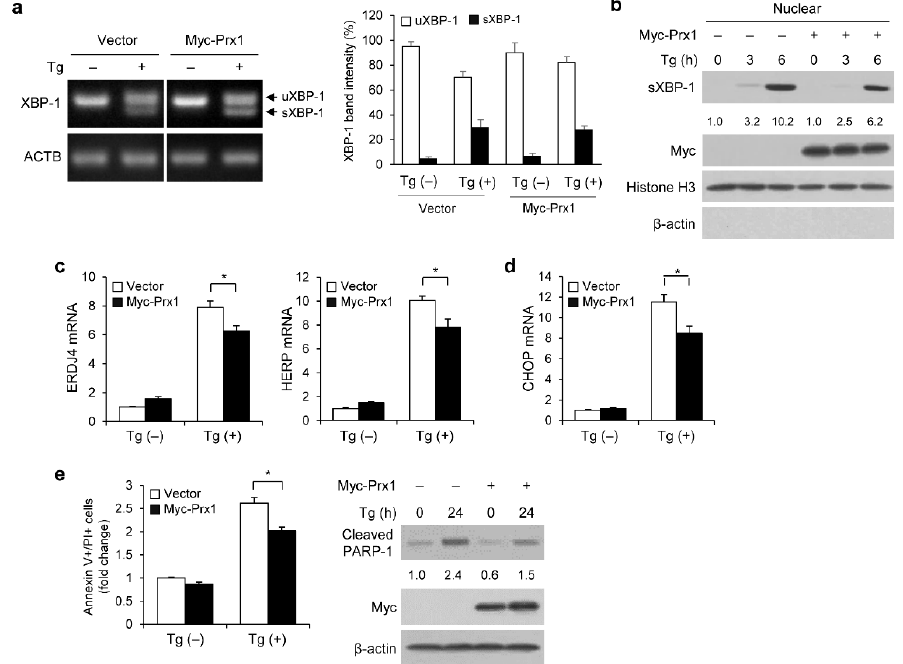
Figure 2. Prx1 inhibits ER stress-induced UPR activation, CHOP pathway, and apoptosis. HEK293 cells were transfected with vector or Myc-Prx1. ( a ) RT-PCR of spliced XBP-1 in transfected HEK293 cells treated with or without 300 nM Tg for 24 h. The band intensity was measured by ImageJ. ( b ) WB of nuclear fraction in transfected HEK293 cells treated with 300 nM Tg for the indicated times. The intensity of sXBP-1 bands was normalized to Histone H3 levls and was quantified using ImageJ software. ( c , d ) Transfected HEK293 cells were incubated with or without 300 nM Tg for 12 h. The mRNA expression levels of ERDJ4 and HERP ( c ) or CHOP ( d ) were analyzed using qRT-PCR. The mRNA levels are shown as fold changes as compared to control vector cells. ( e ) Apoptosis assay of overexpressed Prx1 in HEK293 cells incubated with or without 300 nM Tg for 24 h using the annexin V/PI staining assay. Quantification of annexin V/PI positive cells was expressed as fold change compared to control vector cells. The cleaved PARP-1 protein levels were analyzed using WB. The band intensity of the cleaved PARP-1 level was normalized to β -actin using ImageJ software. Data are indicated as the mean ± SD of three independent experiments (* p <